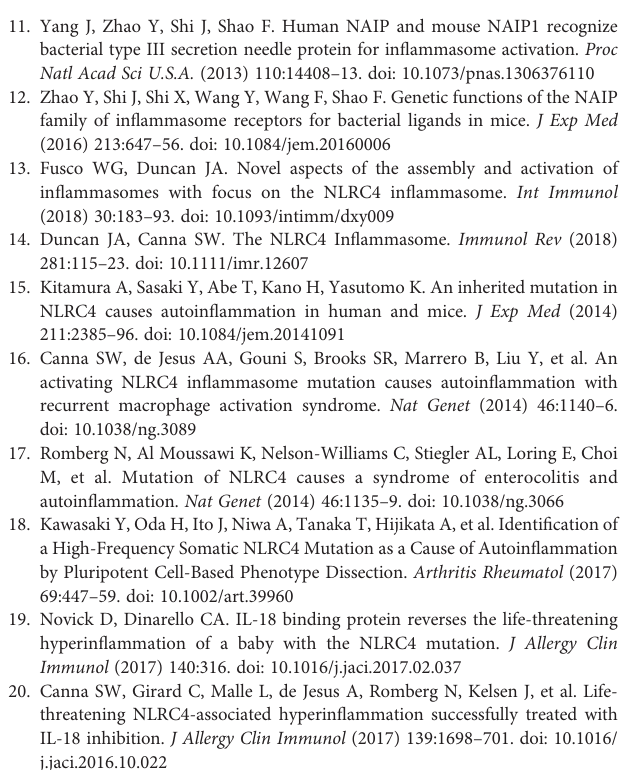
SUPPLEMENTARY FIGURE 1 | Gating strategy for detecting neutrophils . Total spleen cells werestained with7AAD, anti-CD11b and Gr-1 antibodies. In the singlet and 7AAD negative populations, CD11b+Gr-1 high cells were de fi ned as